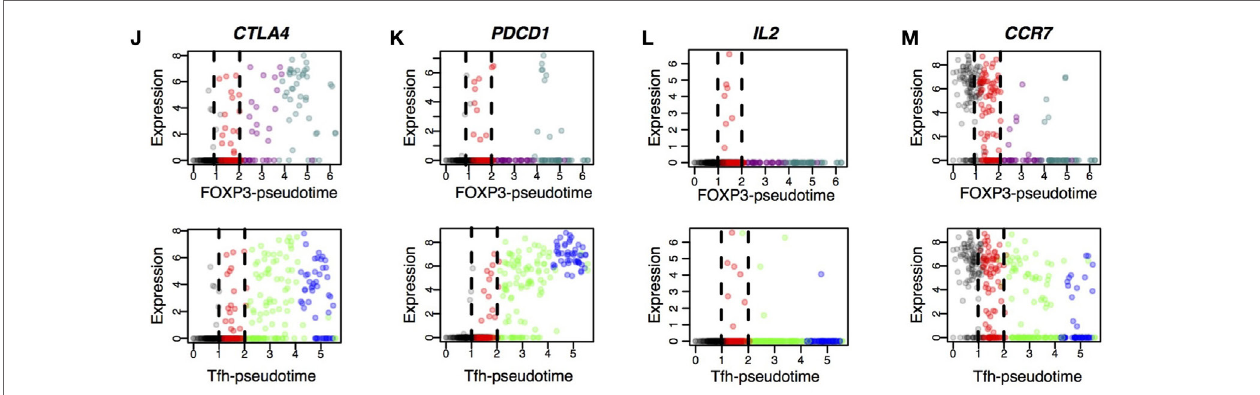
FigUre 9 | Single-cell combinatorial CCA (SC4A) identifies the bifurcation point of activated T cells that leads to T follicular helper (Tfh)-like and Treg differentiation in tumor-infiltrating T cells. SC4A was applied to the single-cell data of tumor-infiltrating T cells, and four genes (CTLA-4, CCR7, FOXP3, and PDCD1) were chosen as explanatory variables to represent the T cell activation, resting, FOXP3-driven process, and Tfh-like process. (a) The design of the analysis. The single-cell data from the melanoma samples were analyzed by SC4A to identify the most effective combinations of explanatory variables for dispersing the four T cell populations identified in Figure 8 . These genes were used as explanatory variables to analyze the rest of the single-cell data as main dataset. Thus, the single-cell level dynamics of T cell differentiation and activation are modeled by the key biological processes that are represented by the T cell populations and explanatory variables. (B) Single-cell sample space of the final SC4A output showing correlations between single-cell samples and the explanatory variables. (c) Gene space of the final SC4A output showing correlations between genes and the explanatory variables. The genes that showed high correlations to the PDCD1, CTLA4, and FOXP3 variables were identified as Tfh-like genes, activation genes, and FOXP3-driven genes, respectively. (D) The identification of two differentiation processes as lineages and a bifurcation point. The cells in the sample space of the SC4A output (B) were classified into six clusters by an unsupervised clustering algorithm. These clusters were further analyzed for pseudotime inference. (e–g) The average gene expression was plotted against each pseudotime (upper: FOXP3- pseudotime; lower: Tfh-pseudotime). The bifurcation point (Cluster II) is emphasized by broken lines. The numbers in circle indicate the cluster number. Gene expression was standardized, and the sum of the standardized expression was obtained for (e) Activation genes, (F) FOXP3-driven genes, and (g) Tfh-like genes (c) . (h–M) The expression of key genes was plotted against each